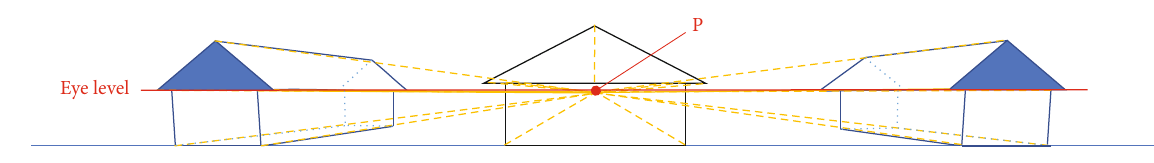
Figure 8: Three house diagrams with one vanishing point.